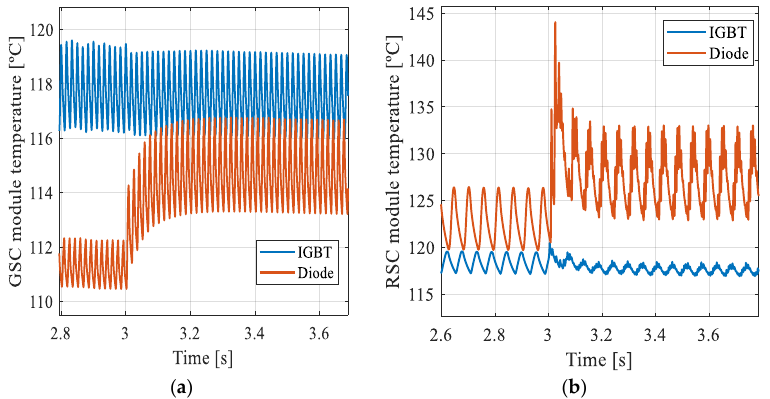
Figure 18. Junction temperature of the power module for an unbalanced sag of 20%: ( a ) GSC module and ( b ) RSC module.